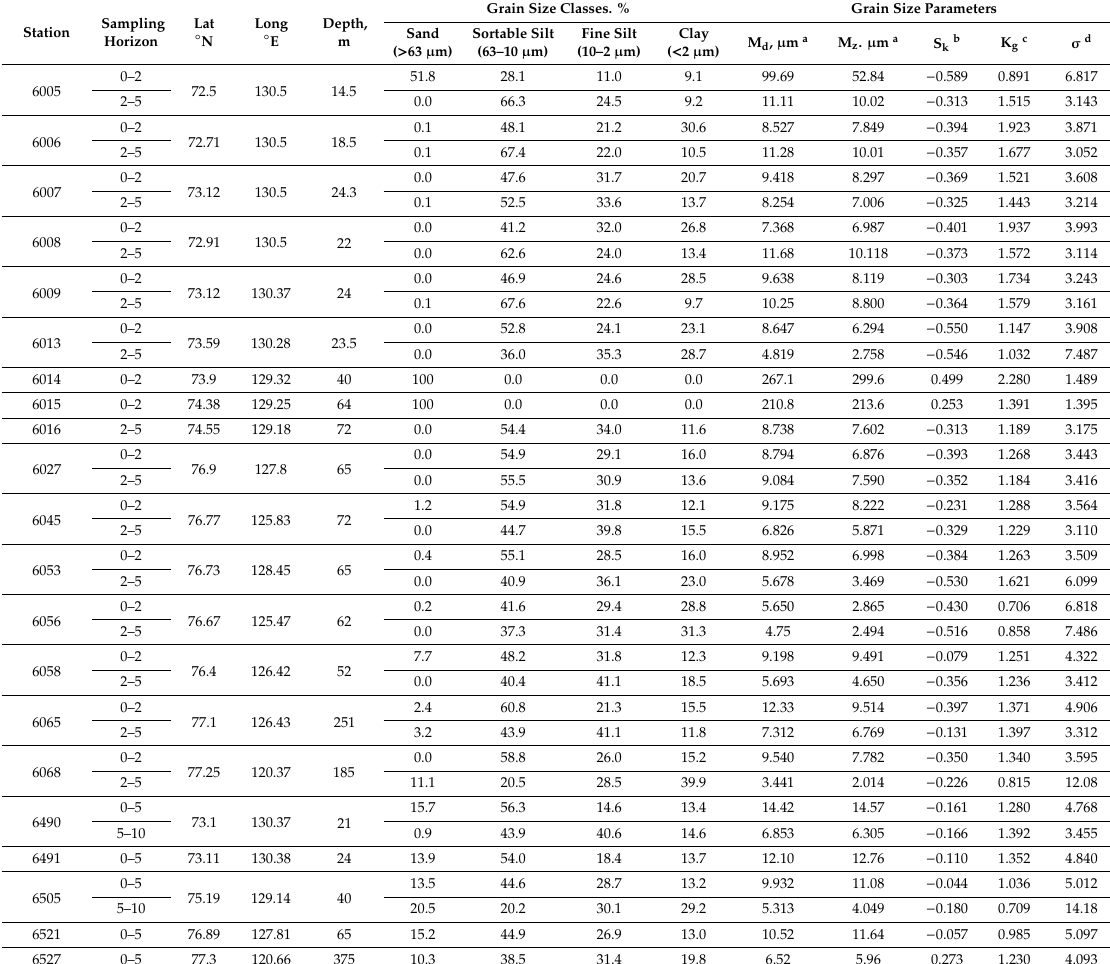
Table 1. Grain size